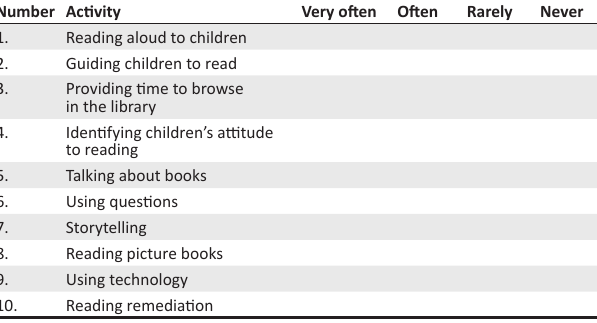
TABLE 1 : Please indicate the frequency of your use of the following activities in your reading